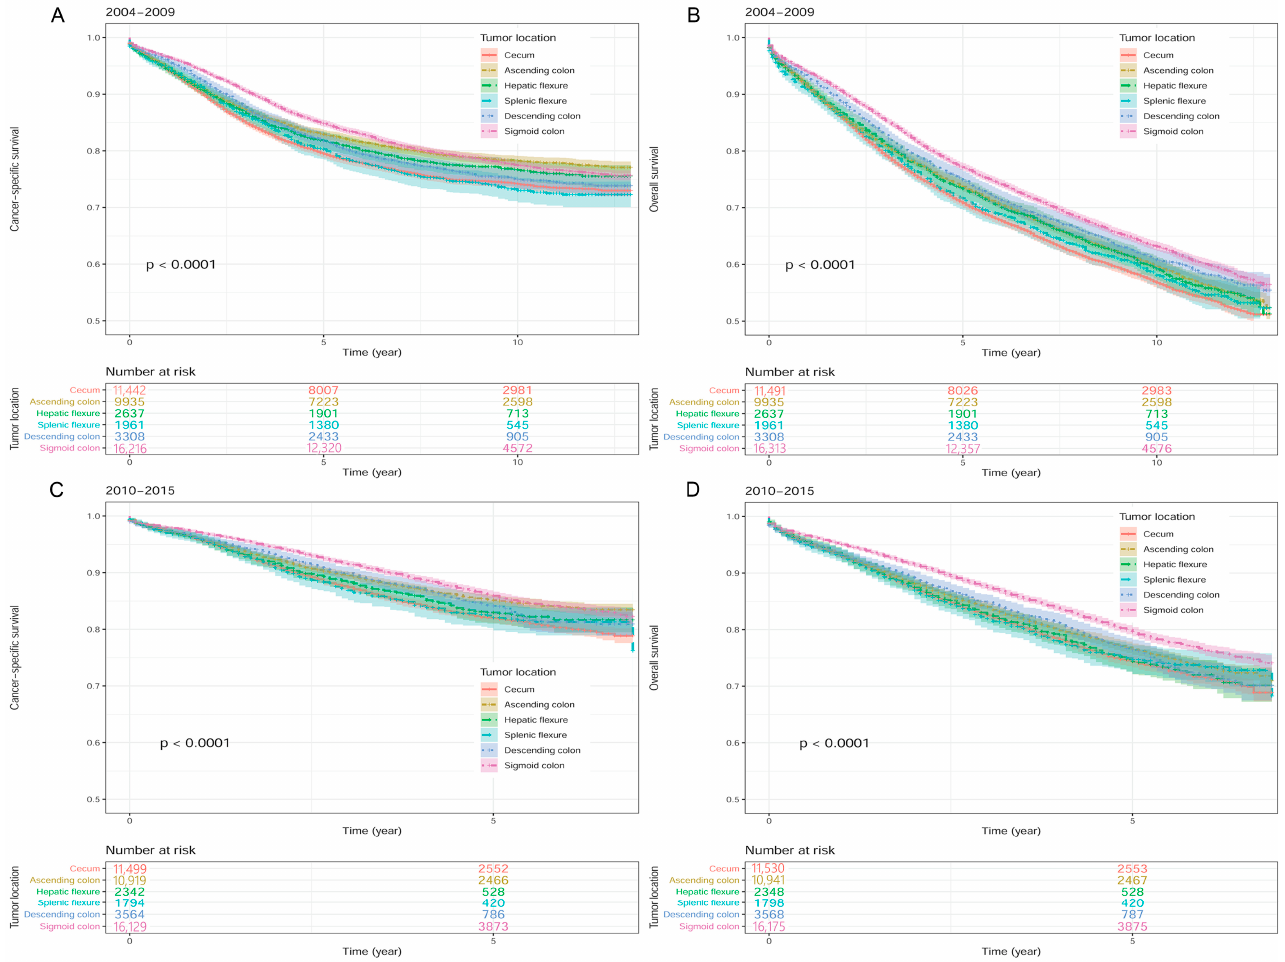
Figure 3. Kaplan-Meier survival curves according to different colon cancer locations in the SEER database. ( A ) Cancer-specific survival in 2004–2009. ( B ) Overall survival in 2004–2009. ( C ) Cancer- specific survival in 2010–2015. ( D ) Overall survival in 2010–2015. Footnotes: S EER , the Surveillance, Epidemiology, and End Results.